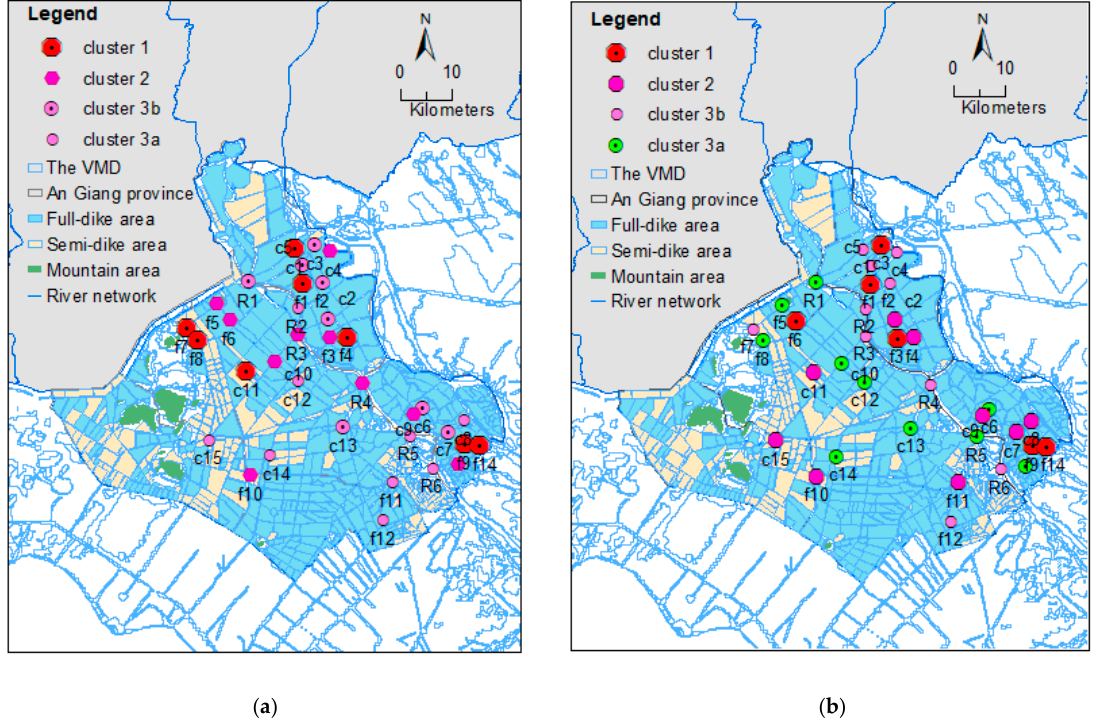
Figure 7. Distribution of surface water quality in the dry season ( a ) and the wet season ( b ) obtained by cluster analysis. There are three main clusters (cluster 1, cluster 2, and cluster 3) and two sub-clusters (cluster 3a and 3b).